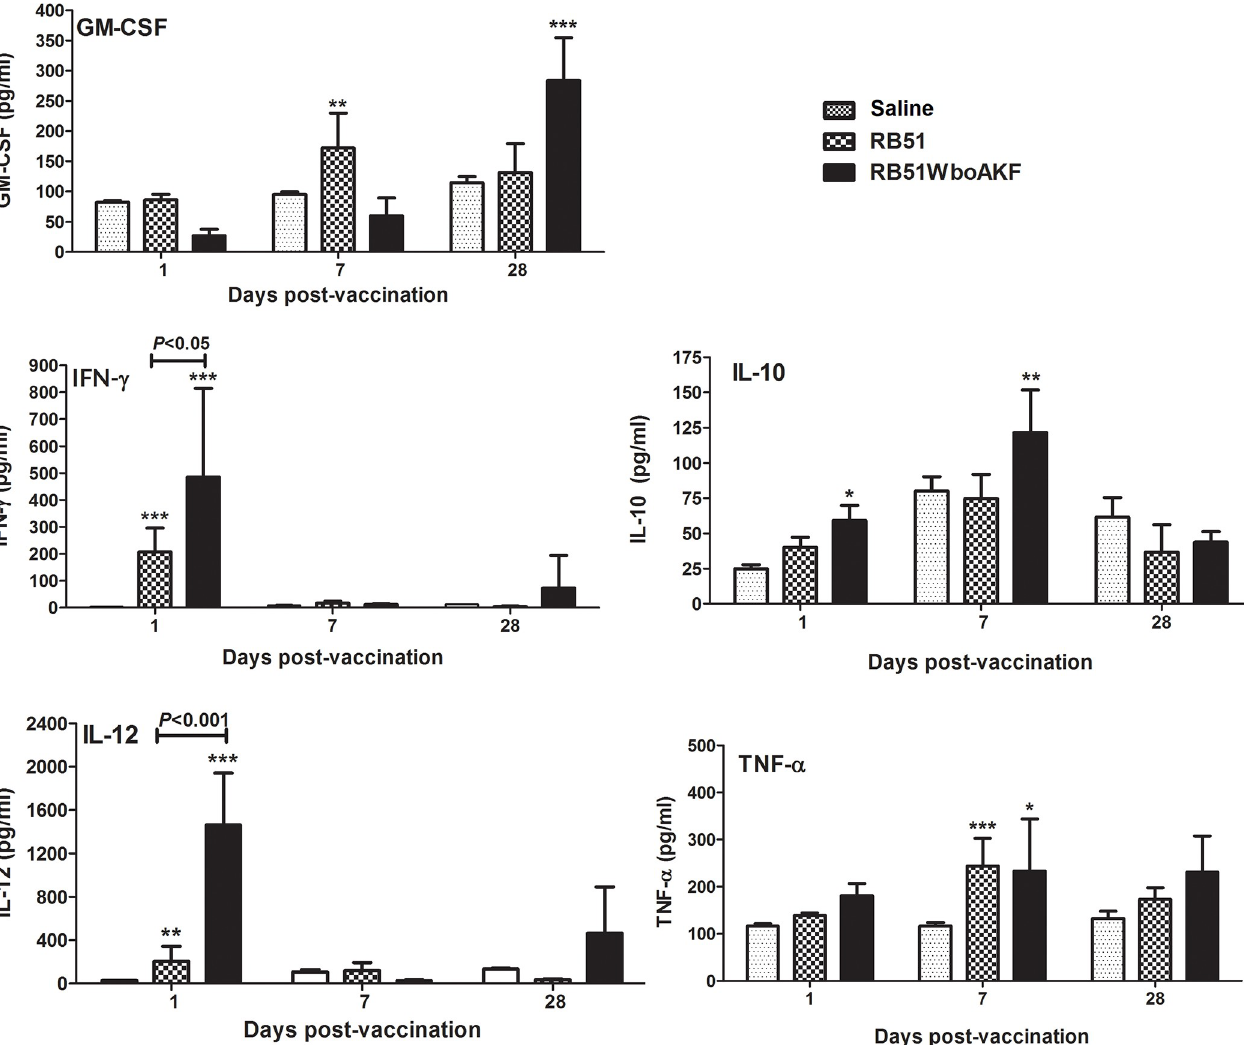
Fig 7. Detection of specific cytokines in the serum of RB51WboAKF vaccinated mice. Mice were immunized intra-peritoneally with 10 8 CFU-equivalent of live RB51, RB51WboAKF, or inoculated with saline. Values are shown as mean ± standard deviation (n = 5). Asterisks indicate statistically significant differences from the corresponding saline group. � , P < 0.05; �� , P < 0.01; ��� , P <